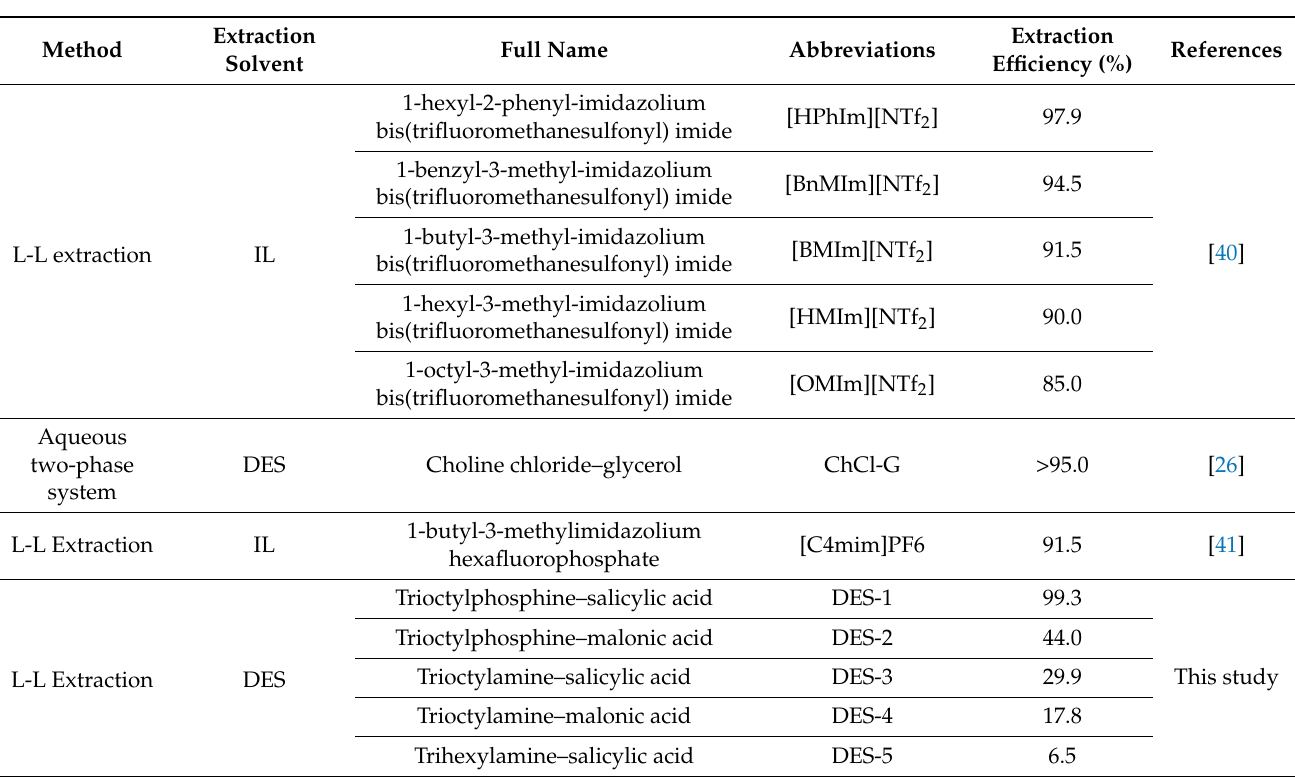
Table 4. Methylene blue extraction efficiency comparison of synthesized DES with other DES- and IL-based extraction solvents.